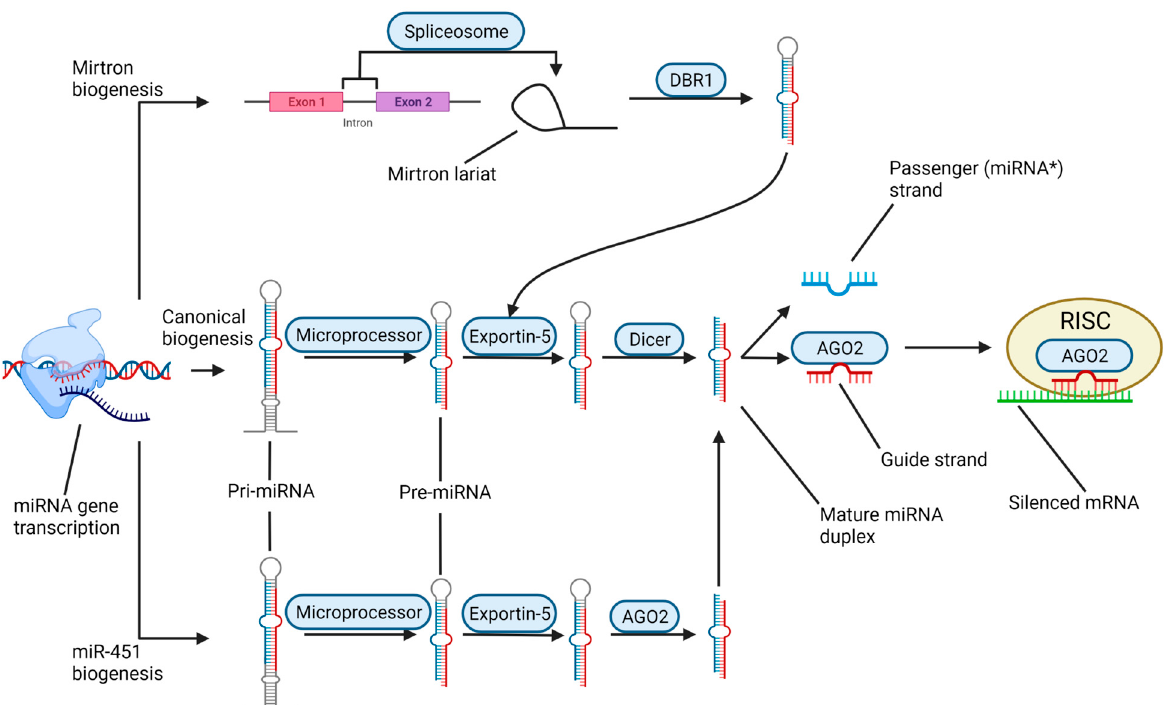
Figure 3. Biogenesis of matured miRNA. The first step for all pathways is the transcription of a miRNA gene by RNA Pol II. In the canonical pathway, the newly formed pri-miRNA hairpin is trimmed by the microprocessor complex in the nucleus to form a pre-miRNA, which is then transported out of the nucleus by Exportin-5. In the cytosol, Dicer cleaved the stem–loop of the pre- miRNA to form the mature miRNA duplex. The guide strand is separated from the passenger strand (miRNA*) and loaded onto Argonaute 2 (AGO2). AGO2 joins the RNA-induced silencing complex (RISC), where the target mRNA is selected by base-pairing with the loaded miRNA. Depending on the completeness of the match, the target mRNA may be either cleaved by AGO2 or be blocked from ribosomal translation. In the noncanonical pathway, Mirtrons are formed from introns during the splicing process. After forming a Mirtron loop, the nascent miRNA is debranched by the DBR1 and processed in the nucleus to form a pre-miRNA, which is then transported out of the nucleus by Exportin-5 and subsequently follows the canonical pathway. The biogenesis of miR-451 is unique in that it is independent of Dicer; after being translated, processed by a microprocessor, and transported out of the nucleus, it binds directly to AGO2, which cleaves it into a mature miRNA duplex.